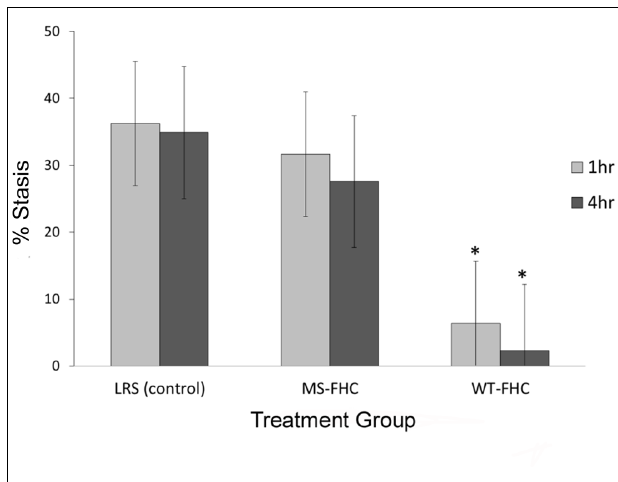
FIGURE 2 | wt-hFHC inhibits hemoglobin-induced stasis in NY1DD sickle mice. Microvascular stasis was measured in a dorsal skin-fold chamber model 8 weeks after hydrodynamic infusion of LRS, ms-hFHC, or wt-hFHC SB vectors. Microvascular stasis was measured 1 and 4 h after infusion of stroma-free hemoglobin (8 μ mol/kg) via the tail vein ( n = 8 per group).Values are mean % stasis ± SD, * p < 0.05 for wt-FHC group vs. both other groups, as calculated by one-way